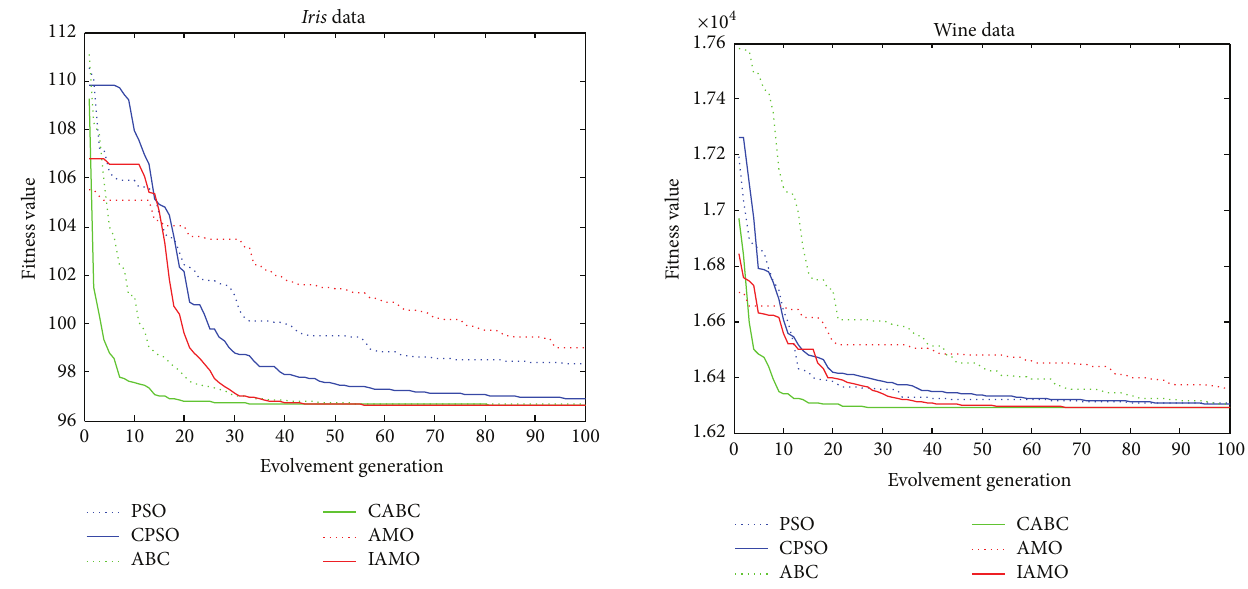
Figure 7: The convergence curve of the Iris data.